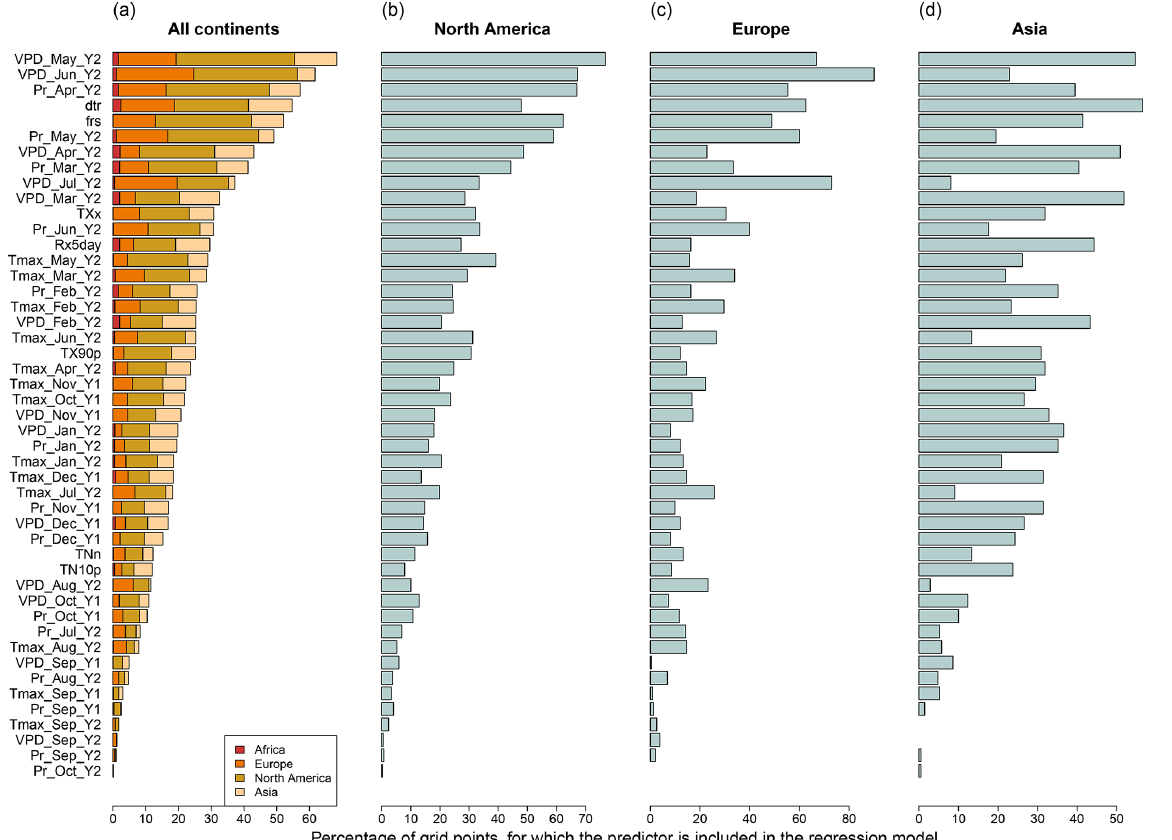
Figure 8. For each possible predictor, we show the percentage of grid points for which this predictor has a non-zero coefficient in the LASSO logistic regression. (a) All continents (889 grid points in total), (b) North America (419 grid points), (c) Europe (233 grid points) and (d) Asia (210 grid points). The extension “Y1” means that the respective month belongs to the first calendar year of the growing season, while “Y2” means it belongs to the second calendar year of the growing